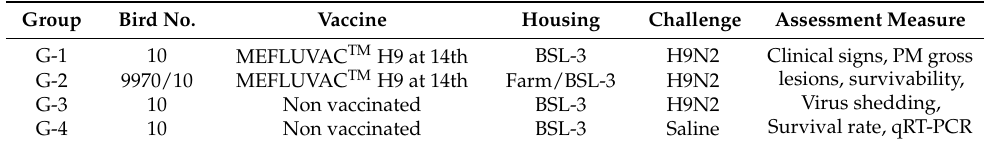
Table 1. Experimental